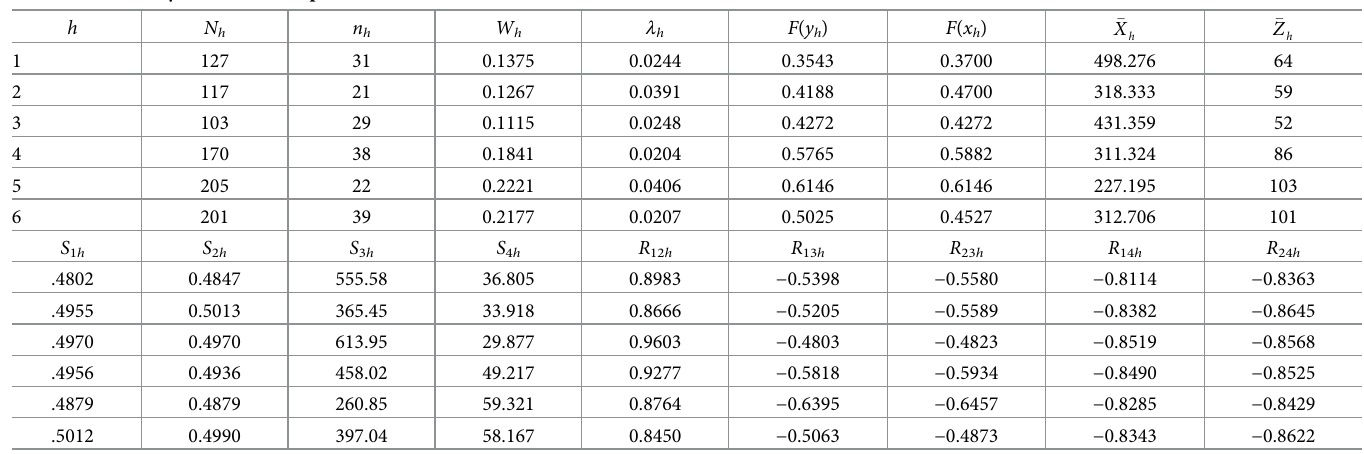
Table 10. Summary statistics for Population II.